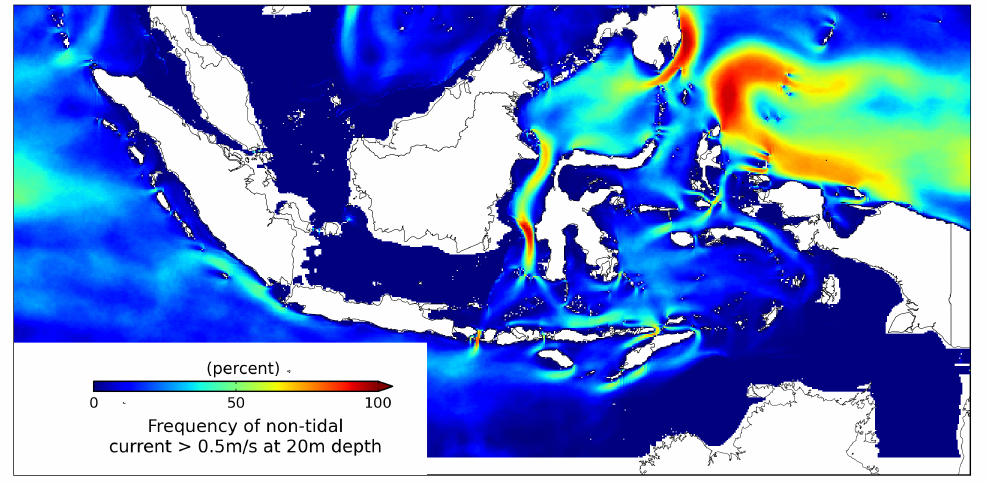
Figure 1. The frequency of non-tidal currents exceeding 0.5 m/s at 20 m depth, diagnosed from the HYCOM global hydrodynamic model. Note the Lombok Strait (see Figure 2) has persistent non-tidal